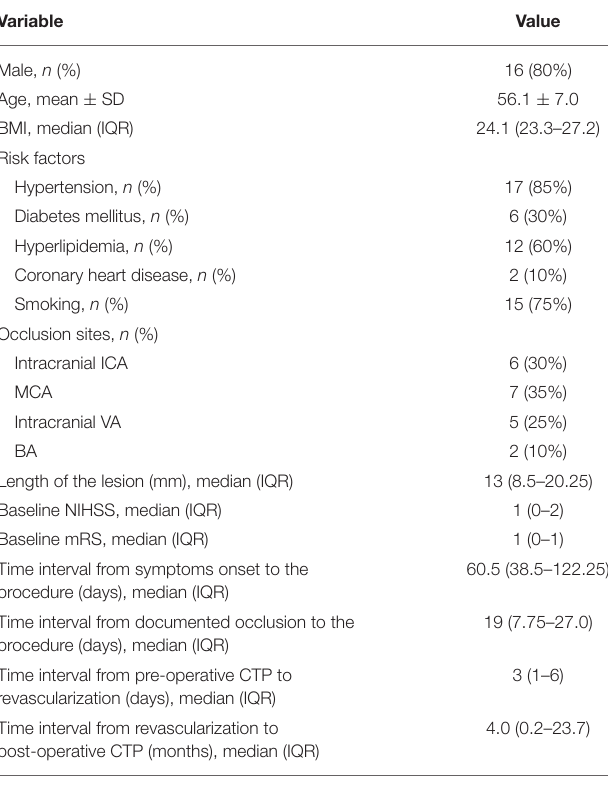
TABLE 1 | Baseline clinical and endovascular treatment characteristics. Variable